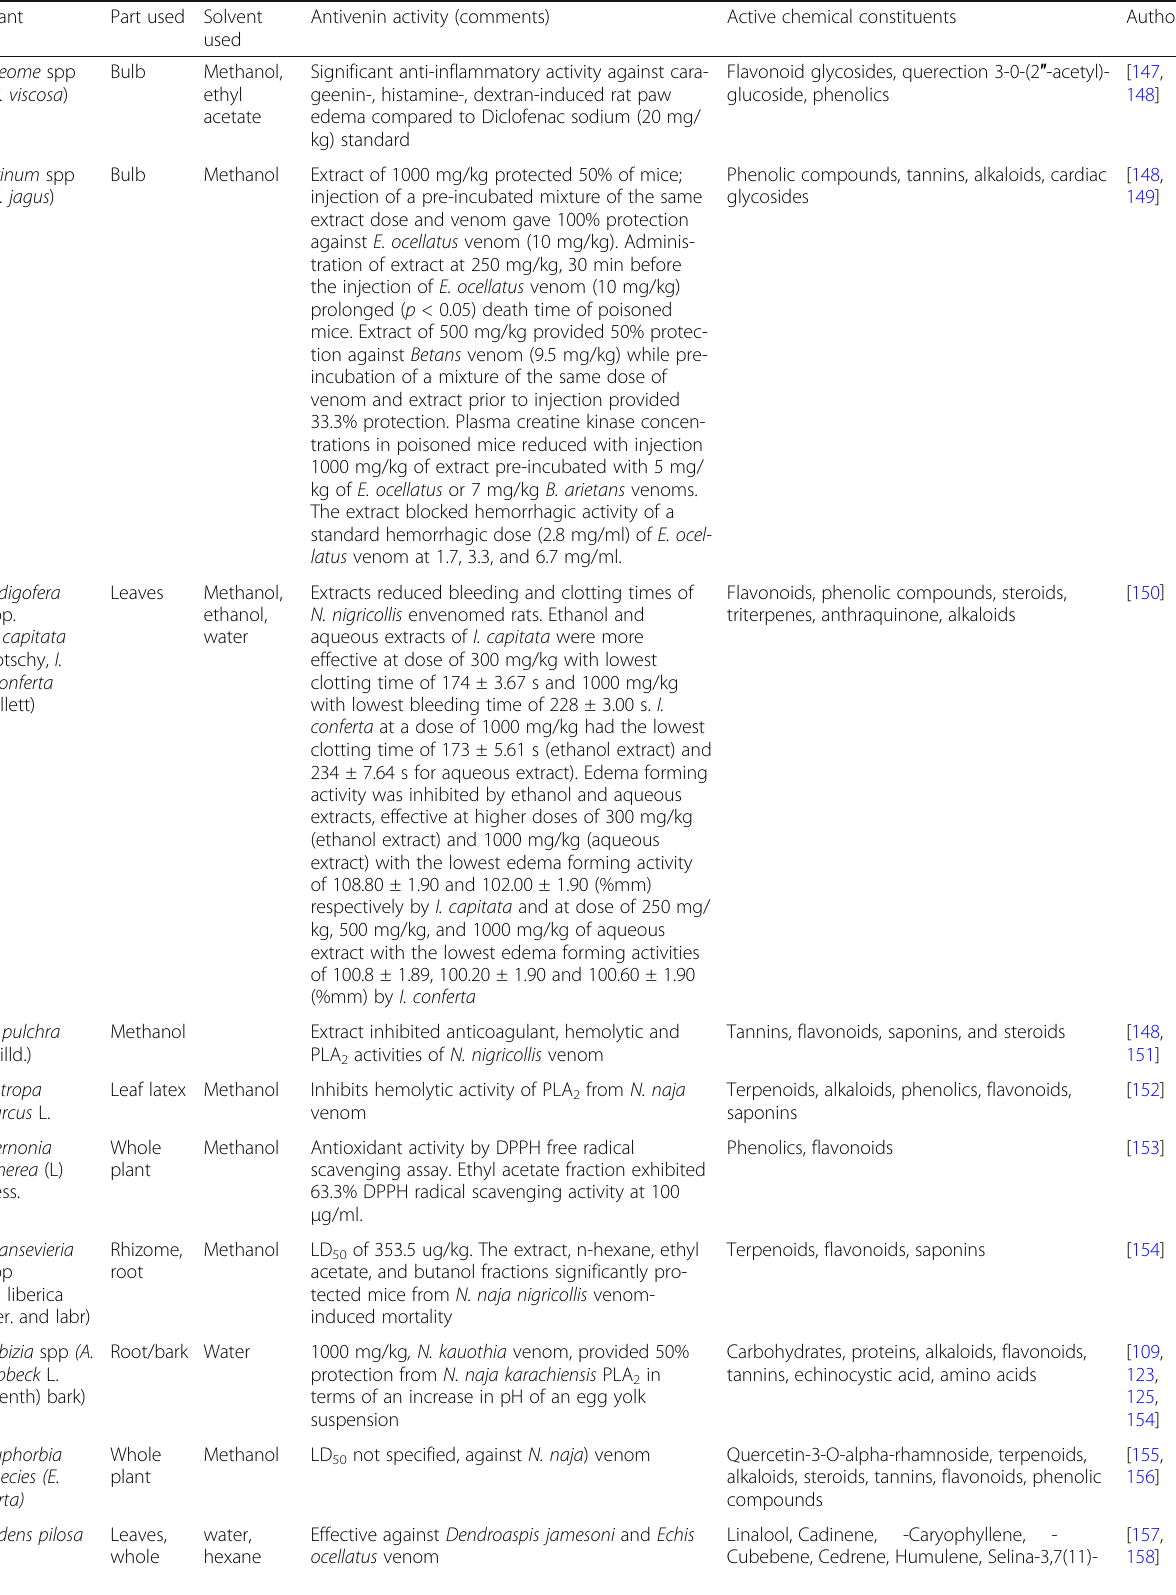
Table 3 Antivenin activities of some plants used for snakebite treatment in Uganda as per global reports